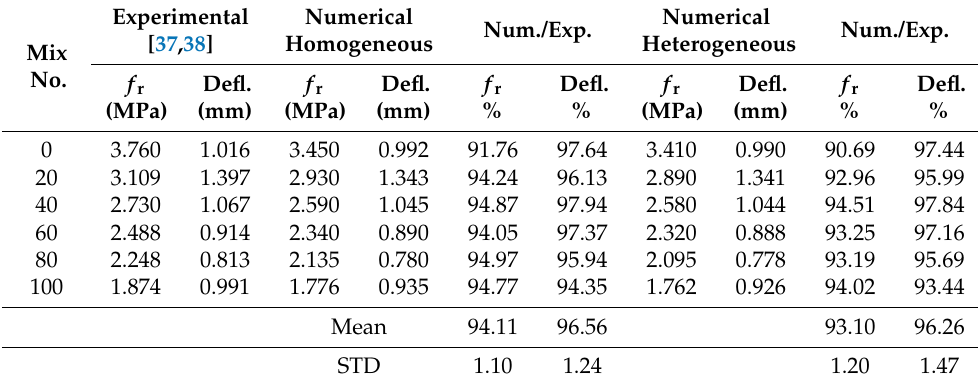
Table 4. Statistical data on the experimental and numerical results of the modulus of rupture and mid-span deflection at the failure